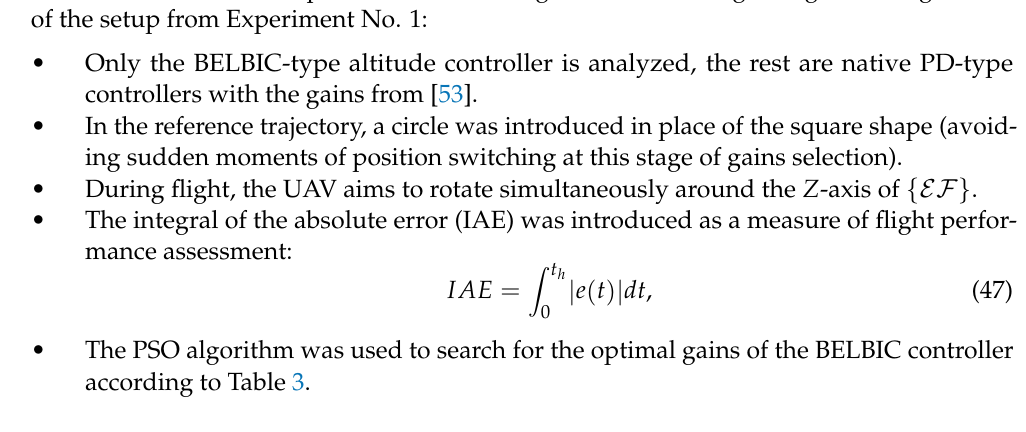
Table 3. Parameters for tuning the BELBIC-type altitude controller using the PSO